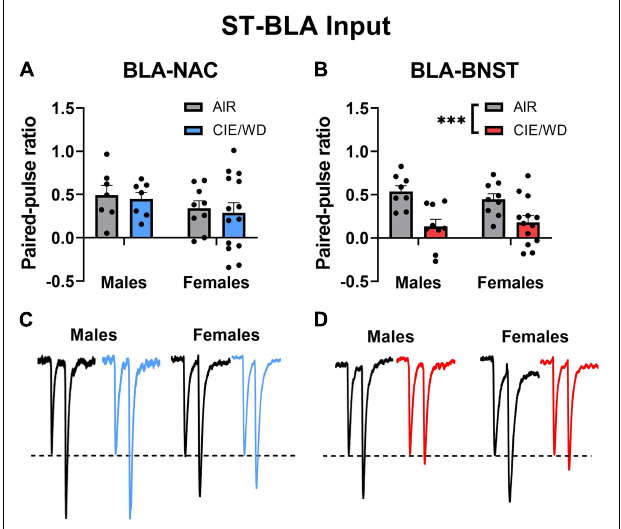
FIGURE 2 | CIE/WD increased glutamate release from stria terminalis inputs onto BLA-BNST neurons. (A) CIE/WD did not affect the PPR in BLA-NAC neurons (Males: n = 7 AIR, 7 CIE/WD; Females: n = 9 AIR, 14 CIE/WD. (B) CIE/WD decreased the PPR in BLA-BNST neurons (Males n = 8 AIR, 9 CIE/WD; Females n = 9 AIR, 13 CIE/WD), suggesting an increase in glutamate release from stria terminalis inputs onto BLA-BNST neurons. (C) Exemplar traces from paired electrical stimuli in BLA-NAC neurons from AIR males, CIE/WD males, AIR females, and CIE/WD females (left to right). (D) Exemplar traces from paired electrical stimuli in BLA-BNST neurons in AIR males, CIE/WD males, AIR females, and CIE/WD females (left to right). All exemplar traces are normalized to the amplitude of the first EPSC to emphasize treatment effects on the PPR (see section “Materials and Methods”). Data analyzed by 2-way ANOVAs. ∗∗∗ p <